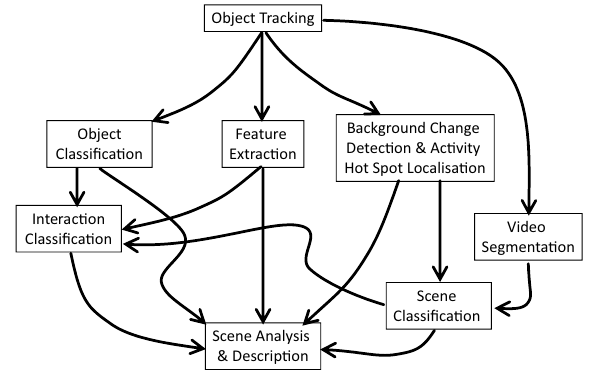
Fig. 1 Proposed approach diagram, where each phase connected to an arrow starting point feeds the phase connected to the termi- nal point of the corresponding arrow